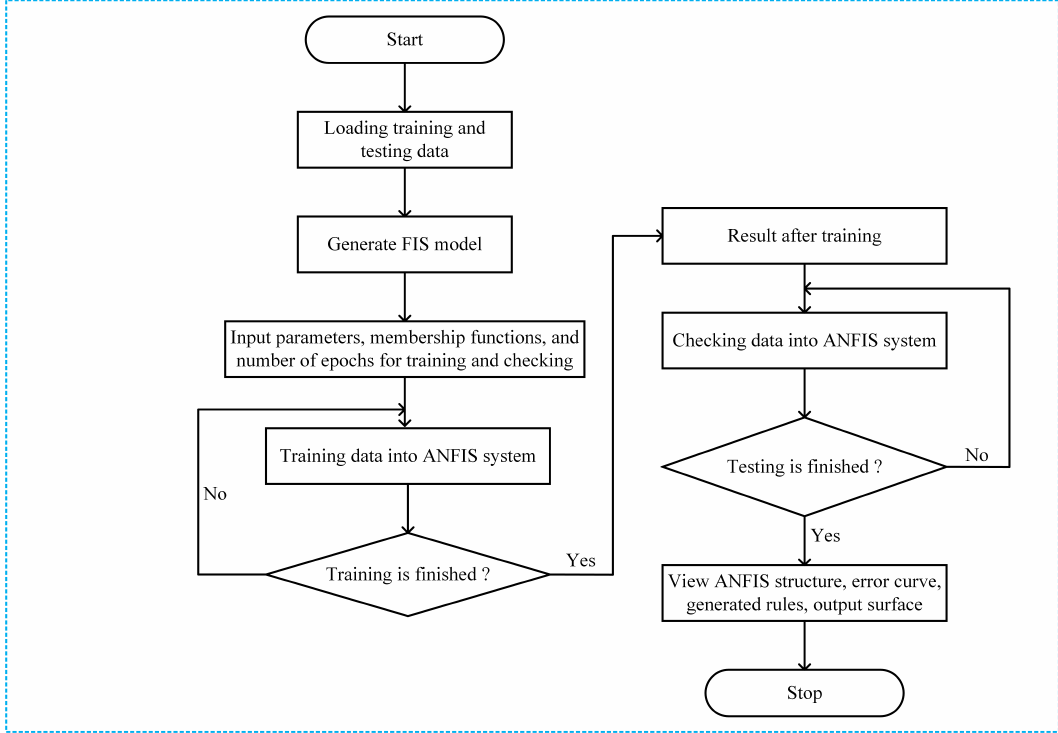
Figure 4. ANFIS training